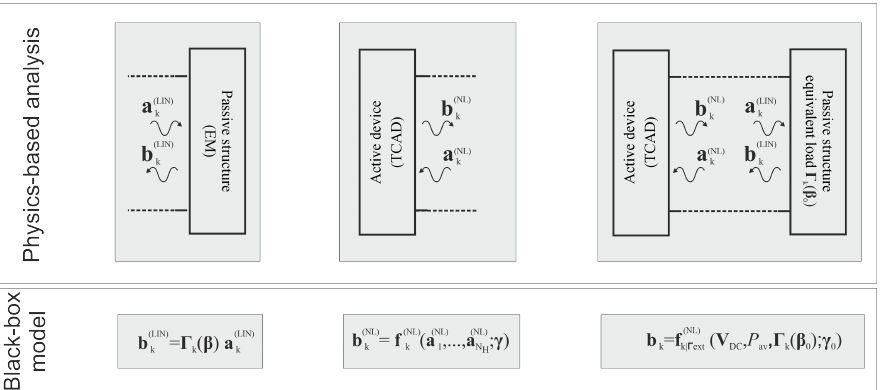
Figure 2. Port representation of the passive linear block ( left ), the active device nonlinear block ( center ), and their connection for harmonic balance simulation ( right ). The case of a 1-port device is shown for simplicity, but the generalization to an N -port is